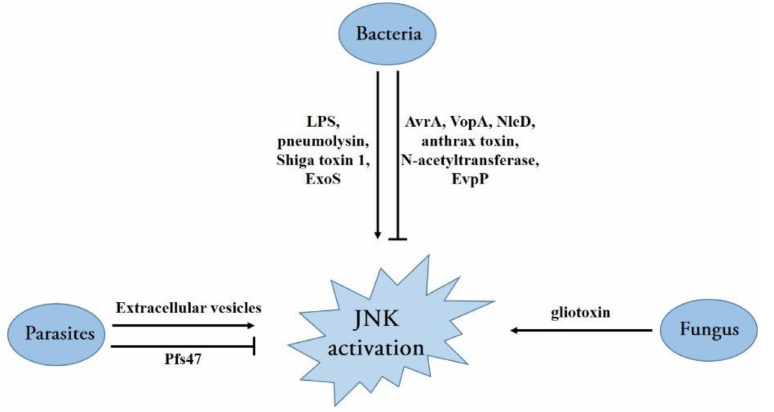
Figure 4. Diagram of various mechanisms of bacteria, fungus, and parasites activating or disrupting the JNK